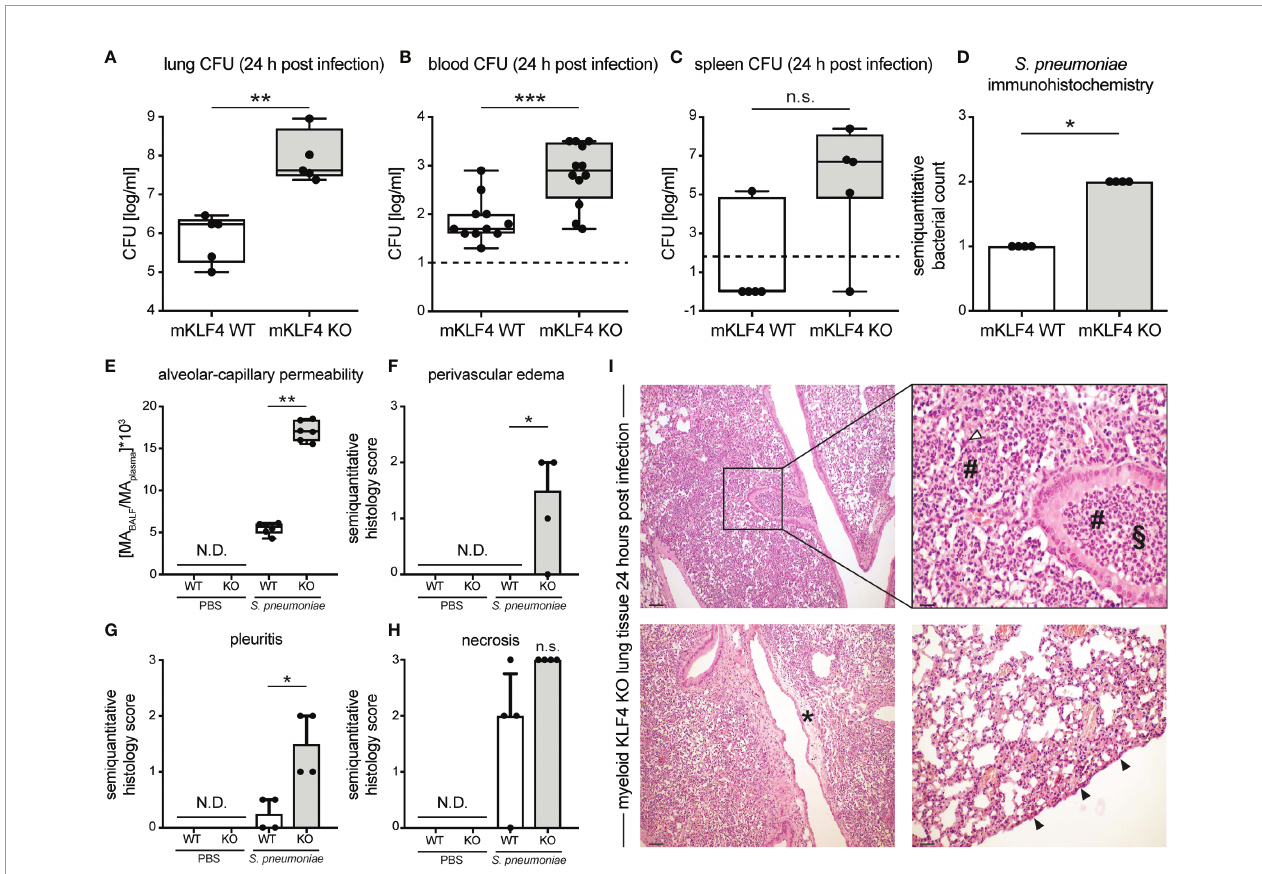
FIGURE 2 | Bacterial load in lungs, blood, spleen and lung tissue damage in myeloid KLF4 knockout and KLF4 wildtype mice 24 hours after transnasal infection with S. pneumoniae . Myeloid KLF4 knockout (mKLF4 KO, KO) and KLF4 wildtype (mKLF4 WT, WT) mice were transnasally inoculated with 5x10 5 CFU NCTC 7978 pneumococci (A – I) or PBS (E – H) . 24 hours after inoculation venous blood was sampled, BAL was performed and mice were sacri fi ced. Bacterial CFUs were determined from lung homogenates (A) , venous blood (B) and spleen homogenates (C) (lower limit of detection lung/spleen homogenates 50 cfu/ml, venous blood 10 cfu/ml, dotted line). Murine albumin (MA) in BALF and plasma was quanti fi ed using ELISA (E) . Whole lung sections were stained using a polyclonal antibody against S. pneumoniae (D) or hematoxylin & eosin (F – I) and semiquantitatively scored for bacterial count (D) , perivascular edema formation (F) , pleuritis formation (G) and necrosis formation (H) . Graphs show boxplots with min to max whiskers on base-10 log scale of 5 mice, each (A, C) , boxplots with min to max whiskers on base-10 log scale of 11 mice (mKLF4 WT) or 12 mice (mKLF4 KO) (B) , median with interquartile range of 4 mice, each (D, F – H) , or boxplots with min to max whiskers on linear scale of 6 mice, each (E) . (I) shows representative sections of lung tissue of mKLF4 KO mice 24 hours after infection with S. pneumoniae (hematoxylin & eosin staining). # PMN in fi ltrate, Δ necrosis formation, § suppurative bronchopneumonia, * perivascular edema formation, ▲ pleuritis formation. Scale bars: 100 µm upper and lower left, 20 µm upper right, and 50 µm lower right picture. Statistics: Mann-Whitney U test (A – E) , or Kruskal-Wallis test with Dunn multiple-comparisons test (F – H) . *p < 0.05, **p < 0.01, *** < 0.001, n.s., not signi fi cant; N.D., not